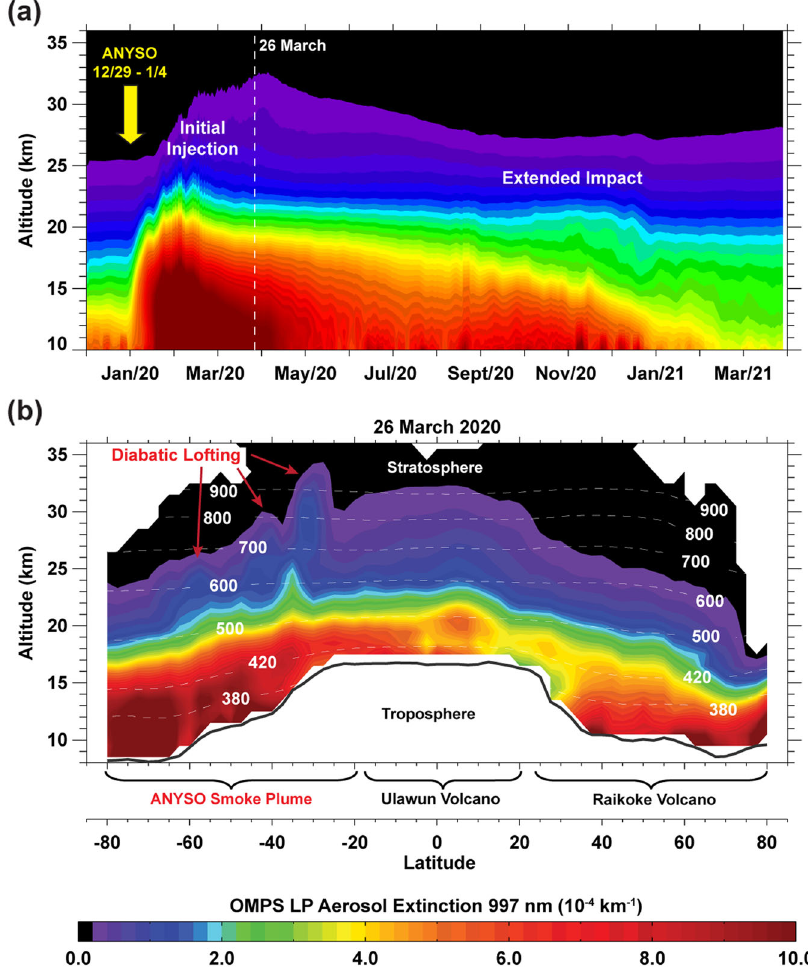
Fig. 9 Smoke plume evolution and persistence in the stratosphere. a Daily aerosol extinction pro fi les at 997 nm between 20°S and 90°S measured by OMPS LP from 01 December 2019 through 29 March 2021. The display is only for pro fi les in the stratosphere, measured at least 1 km above the mean tropopause altitude. b Zonally averaged aerosol extinction pro fi les at 997 nm, calculated for 2.5° latitude bands on 26 March 2020. The black line denotes the mean tropopause altitude and the white contours are mean potential temperature (K). The primary source of stratospheric aerosols in certain latitude bands is speci fi ed at the